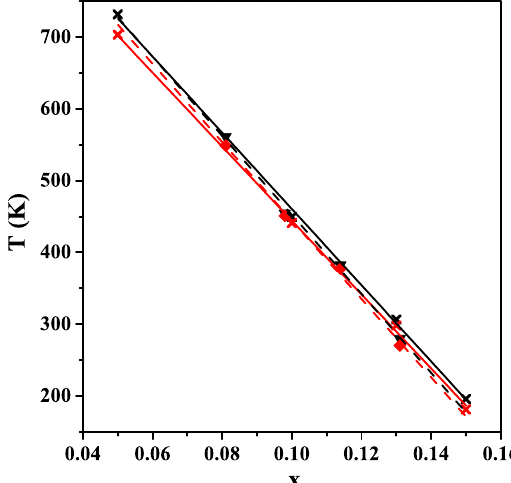
Figure 11. The comparison of exothermic (red dashed line with diamond) and endothermic (black dashed line with triangle) peak temperatures in annealed alloy films, against previously reported average martensitic (red solid line with × ), ( M s + M f )/2, and the reverse (black solid line with × ), ( A s + A f )/2, transformation temperatures for bulk alloys (Ni 0.5 Mn 0.5 − x Sn x ) by linear regression 46,49,50